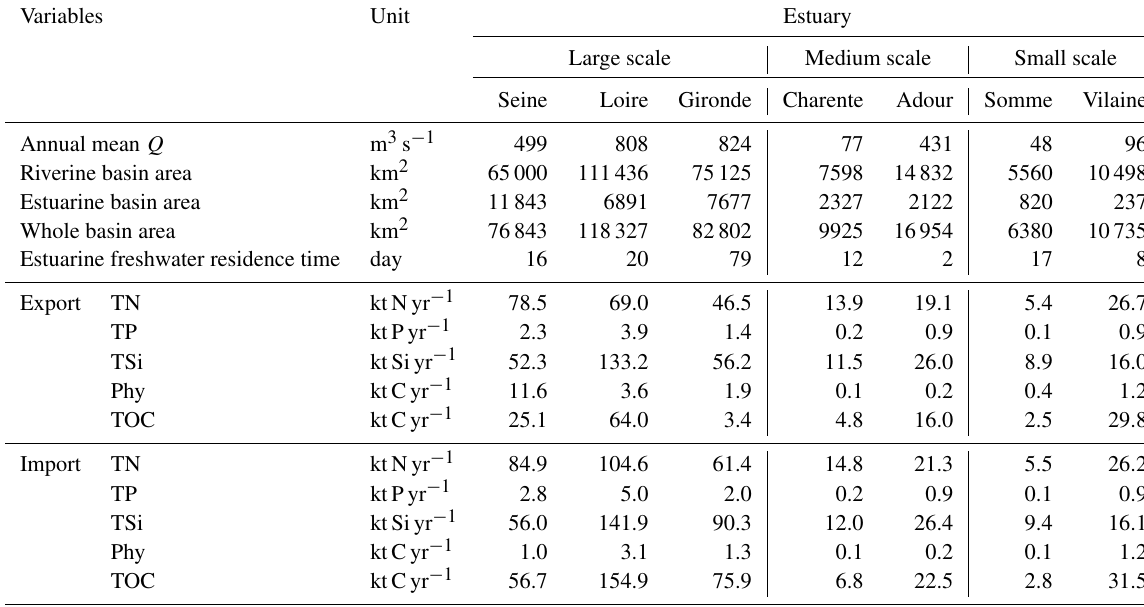
Table 8. The mean annual (2014–2016) import and export of nutrients, i.e., total nitrate (TN), total phosphorus (TP), total silicate (TSi), phytoplankton (Phy), and total organic carbon (TOC), for the estuaries studied. The export fluxes are calculated by the model, while import ones are observed after interpolation of the water quality variables.